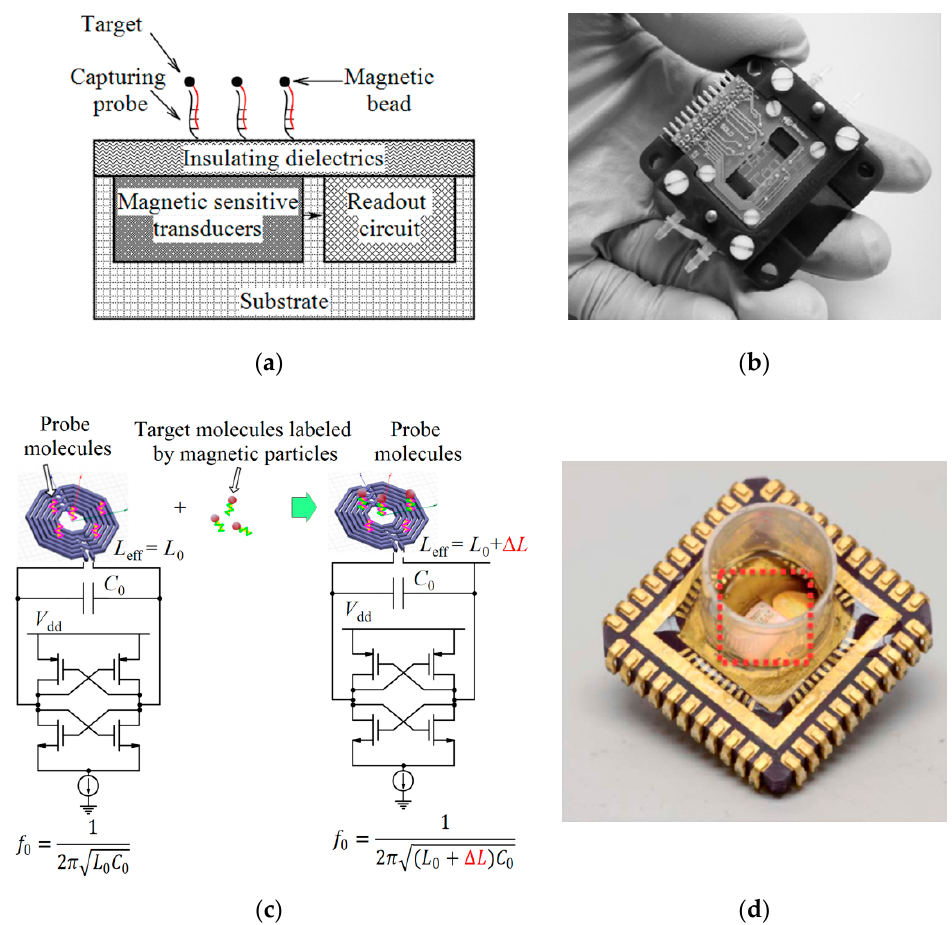
Figure 13. ( a ) Magnetic-based detection, ( b ) Packaged magnetoresistive immunosensor biosensor reported in [39] , ( c ) Frequency-shift magnetic sensor sensing mechanism, ( d ) The disposable cartridge including an electrically connected magnetic-based biosensor chip inside a polypropylene well [105] .